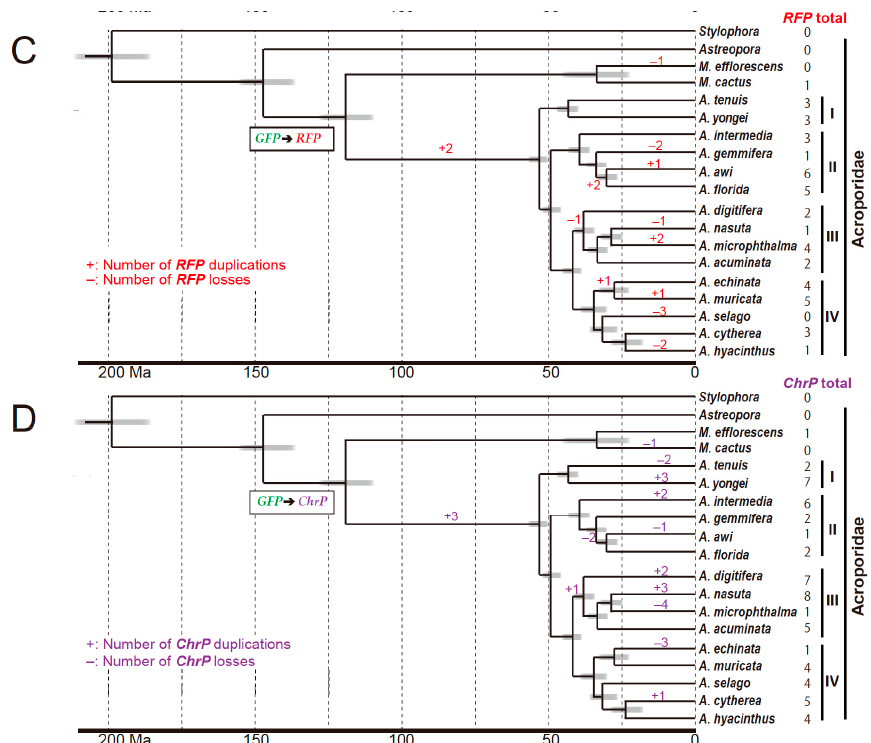
Figure 2. Expansions of the fluorescent protein (FP) genes of the genus Acropora with estimated divergence times of the acroporid corals indicated at the bottom of each tree. Numbers of genes duplicated (+) or lost (–) are indicated at each branch. ( A ) FP gene duplications and losses. It is inferred that the Acroporidae ancestor had five FPs . Species trees with divergence time estimates, changes in sea level, and sea surface temperature are indicated [22]. Expected sea level changes are shown with a blue dotted line [59]. Estimated tropical sea surface temperature of the Eocene is indicated with an orange line [60]. The Paleocene–Eocene thermal maximum (PETM) is indicated with an arrowhead, and the Early Eocene climatic optimum (EECO) is highlighted in light grey. An approximate geological time scale is shown at the bottom. J, Jurassic period; C, Cretaceous period; P, Paleocene; E, Eocene; O, Oligocene; M, Miocene. The history of FP duplications and losses are classified into those of GFP / CFPs ( B ), RFPs ( C ), and ChrPs ( D ). Squares show that putative